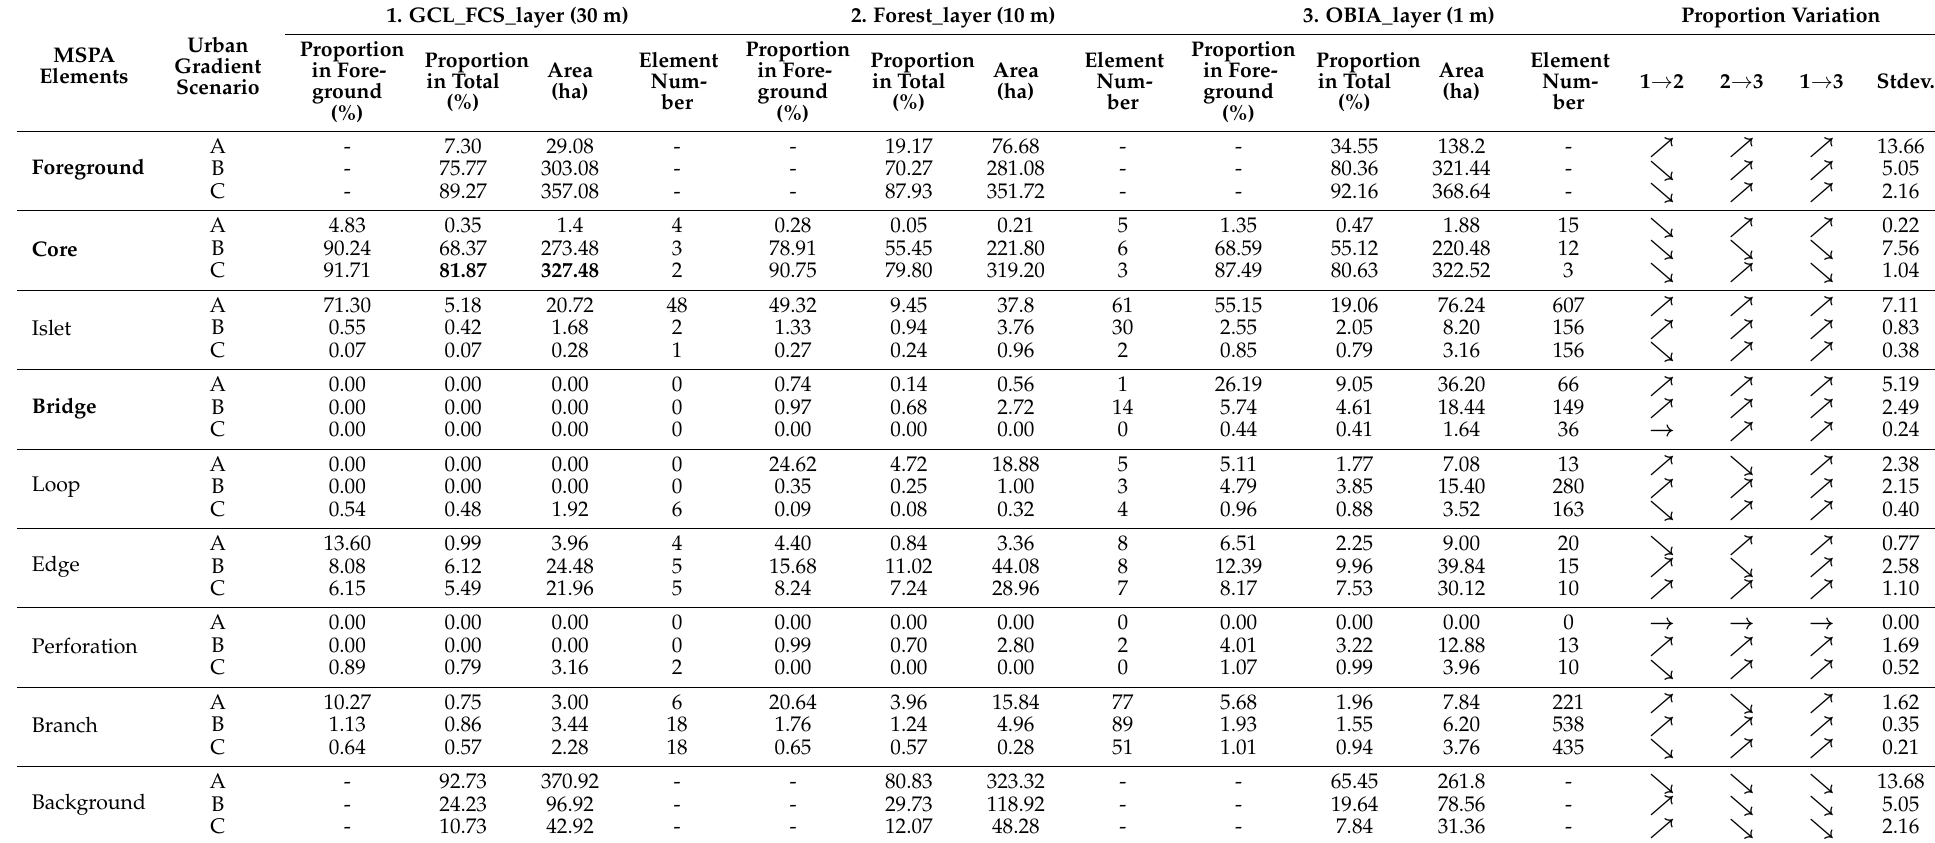
Table 2. An inventory table of MSPA results for the three UGS cover maps. The proportion variation column displays the variation tendency of the proportion in total from low spatial resolution map to high-resolution